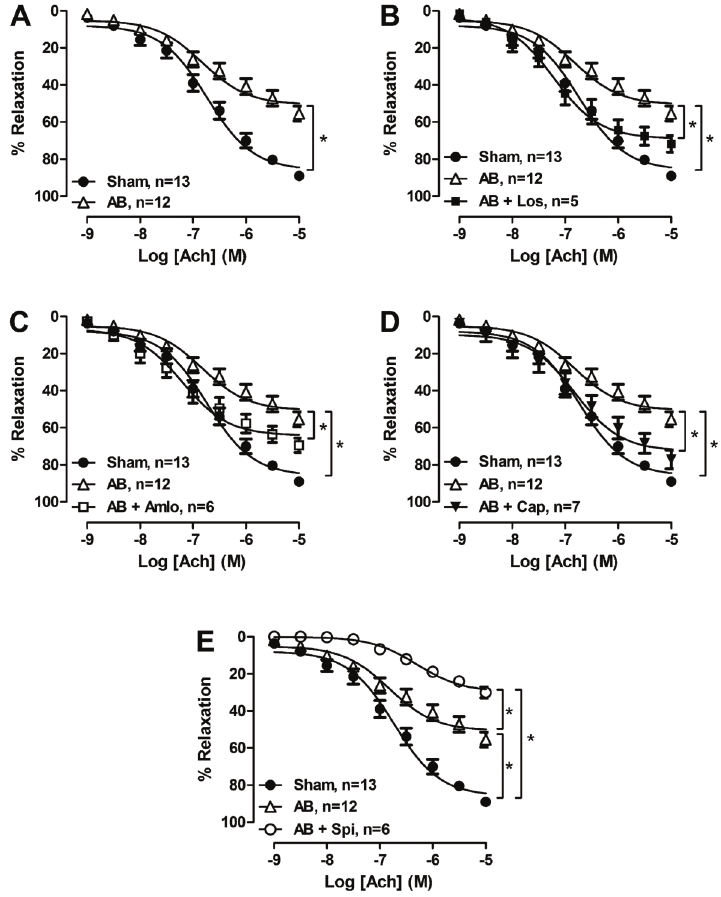
Figure 2. A , Effect of acetylcholine (Ach) on the vasorelaxation in aortic rings from rats that underwent aortic banding (AB). Effect of chronic treatment with ( B ) losartan, ( C ) amlodipine, ( D ) captopril or ( E ) spironolactone (5 mg/kg of body weight per day) in response to Ach in aortic rings from AB rats. Data are reported as means ± SE. Los: losartan; Amlo: amlodipine; Cap: